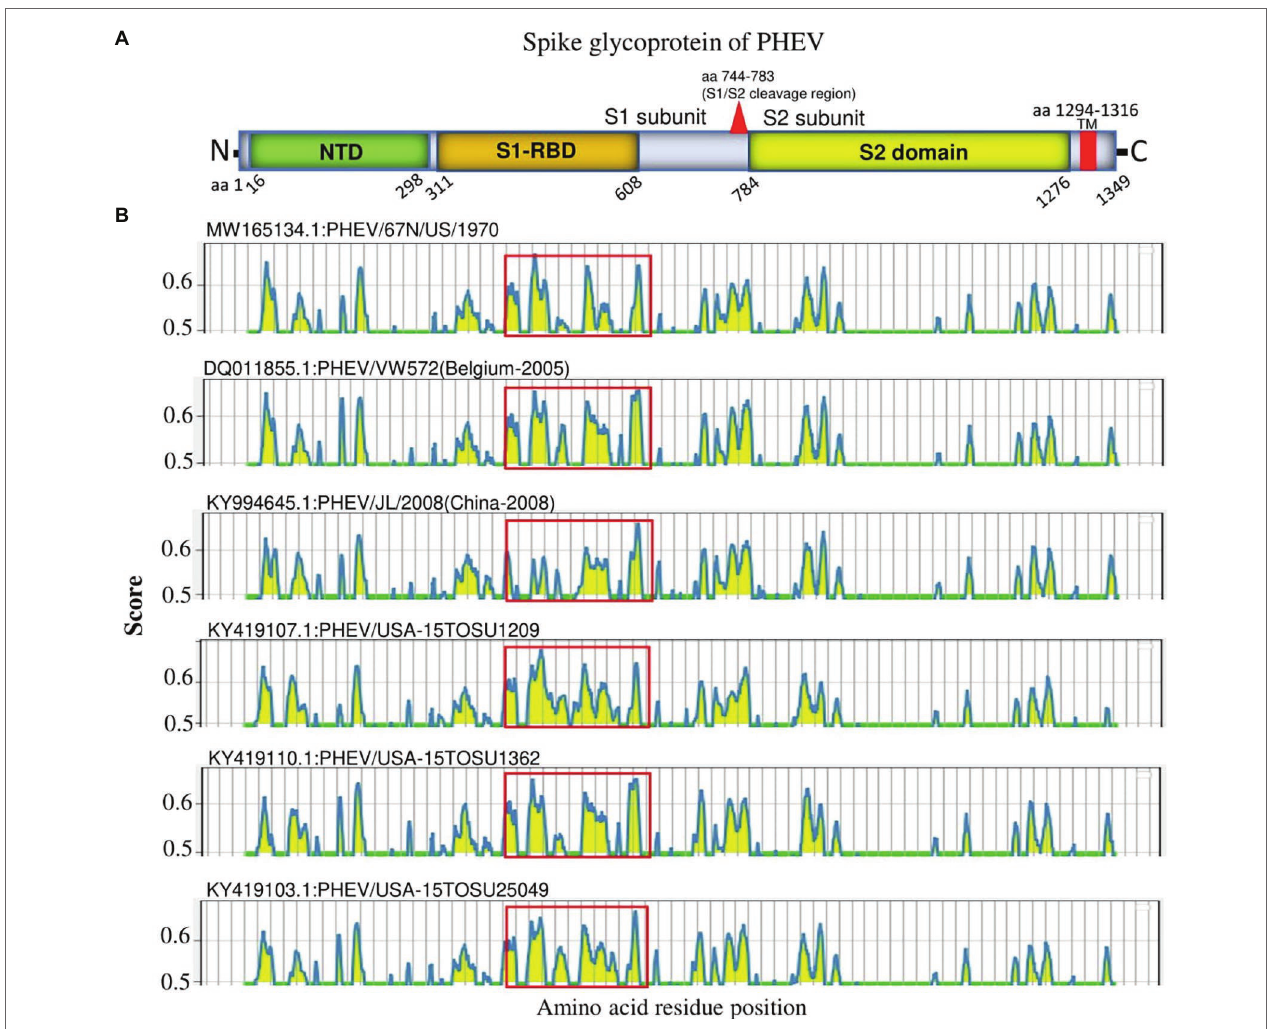
FIGURE 4 | Linear B cell epitope map of the full-length S glycoprotein of PHEV. (A) Diagram of the main features of PHEV S glycoprotein, including NTD (aa 16–298), S1-RBD (aa 311–608), S2 domain (aa 784–1,276), and transmembrane domain (TM; aa 1,294–1,316). Numbers refer to the amino acid positions corresponding to PHEV/67 N/US/1970 S glycoprotein. (B) Mapping of linear B cell epitopes using the BepiPred-2.0 server. The Y -axes represents the residue score, and the X-axes represents the amino acid position, which is also relative to the diagram on the top (A) . The predicted epitopes are indicated in